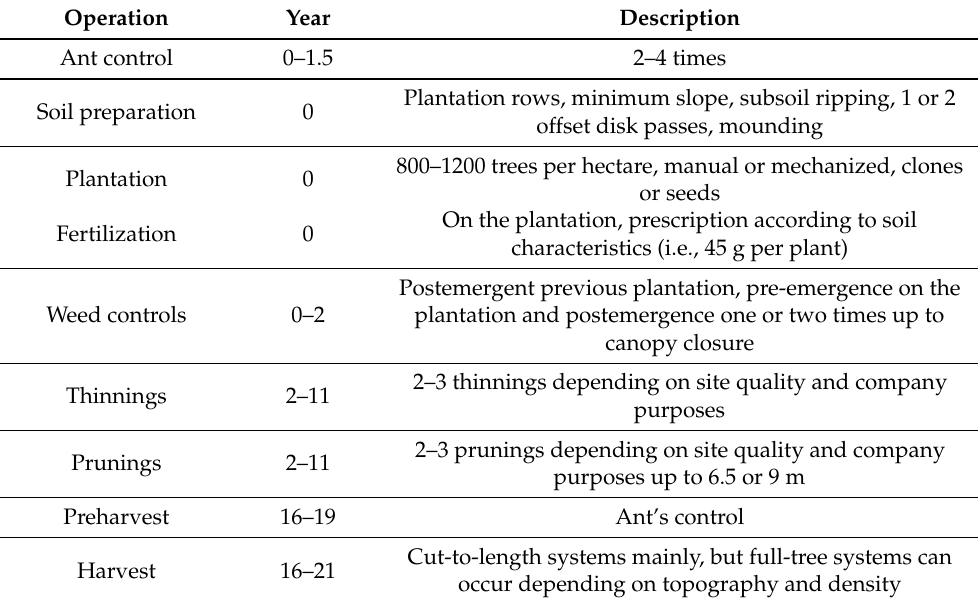
Table 5. Operations of Eucalyptus plantations for sawmills and plywood